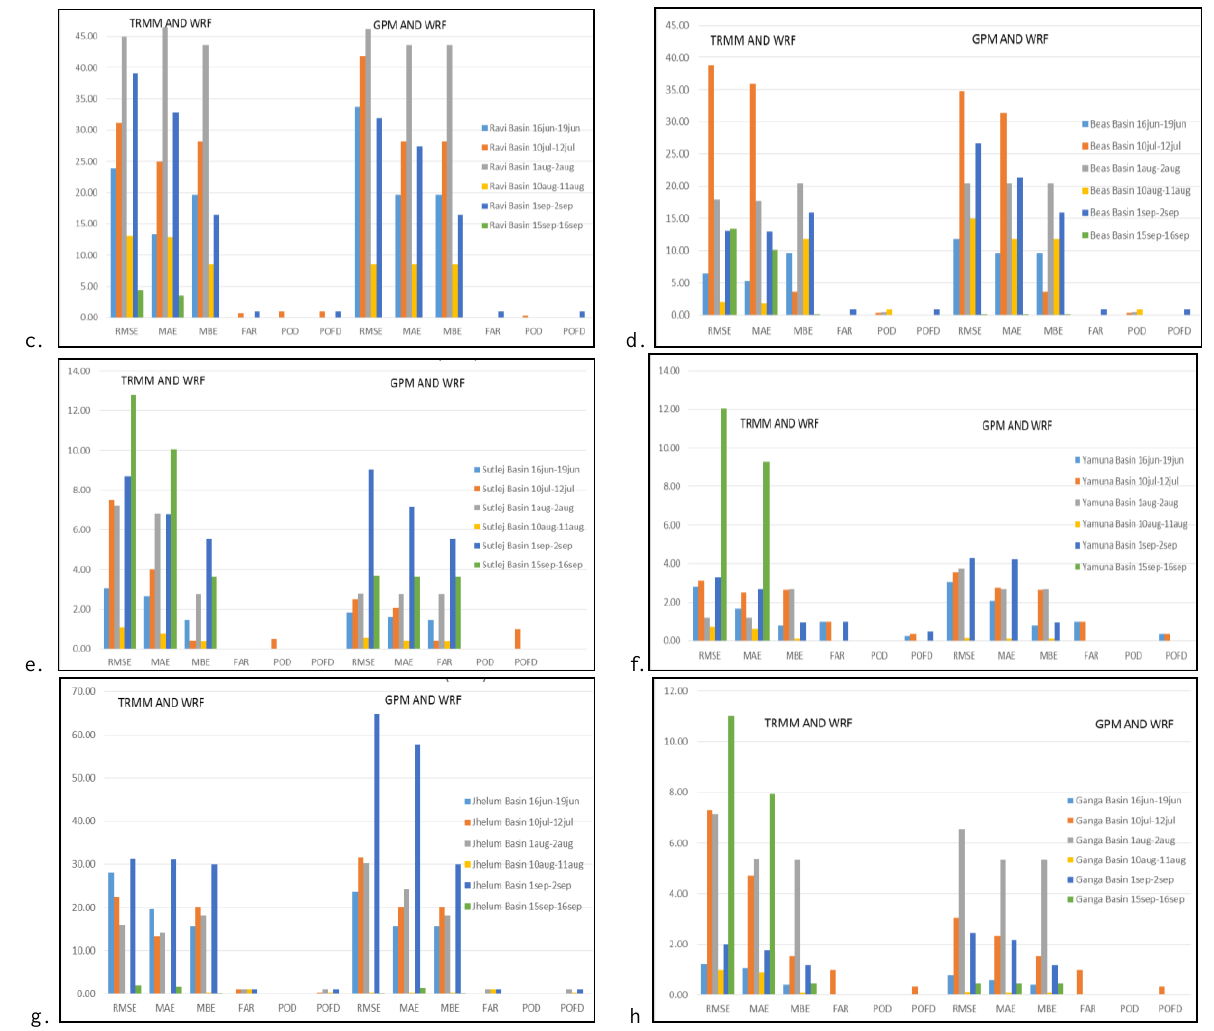
Figure 10: WRF data verification w.r.t. satellite products for (a) Indus, (b) Chenub, (c) Ravi, (d) Beas, (e) Sutlej, (f) Yamuna, (g) Jhelum, (h) Upper Ganga basins in the year